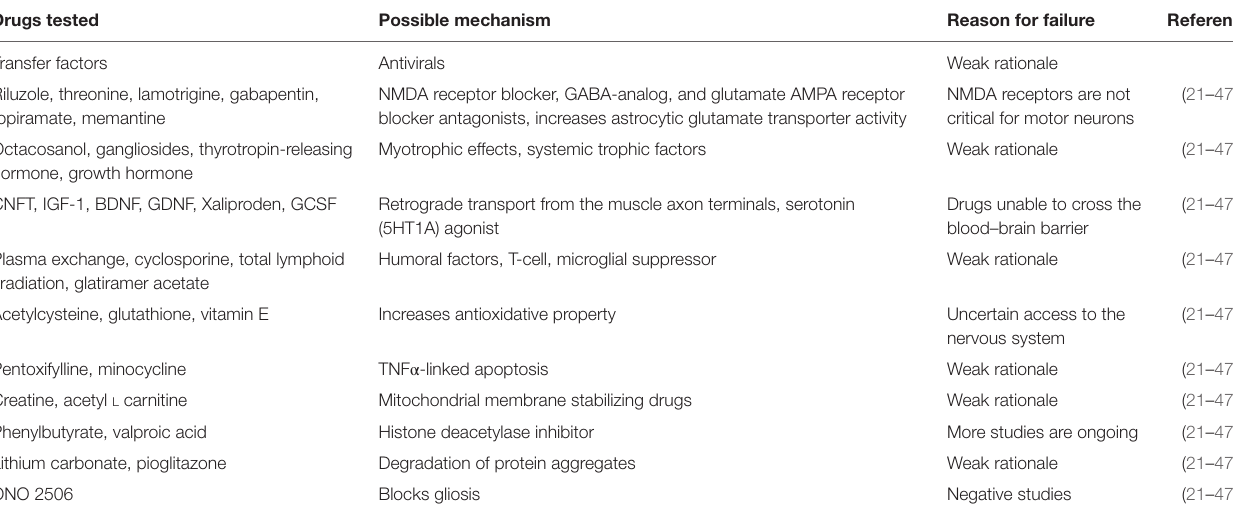
Drugs tested Possible mechanism Reason for